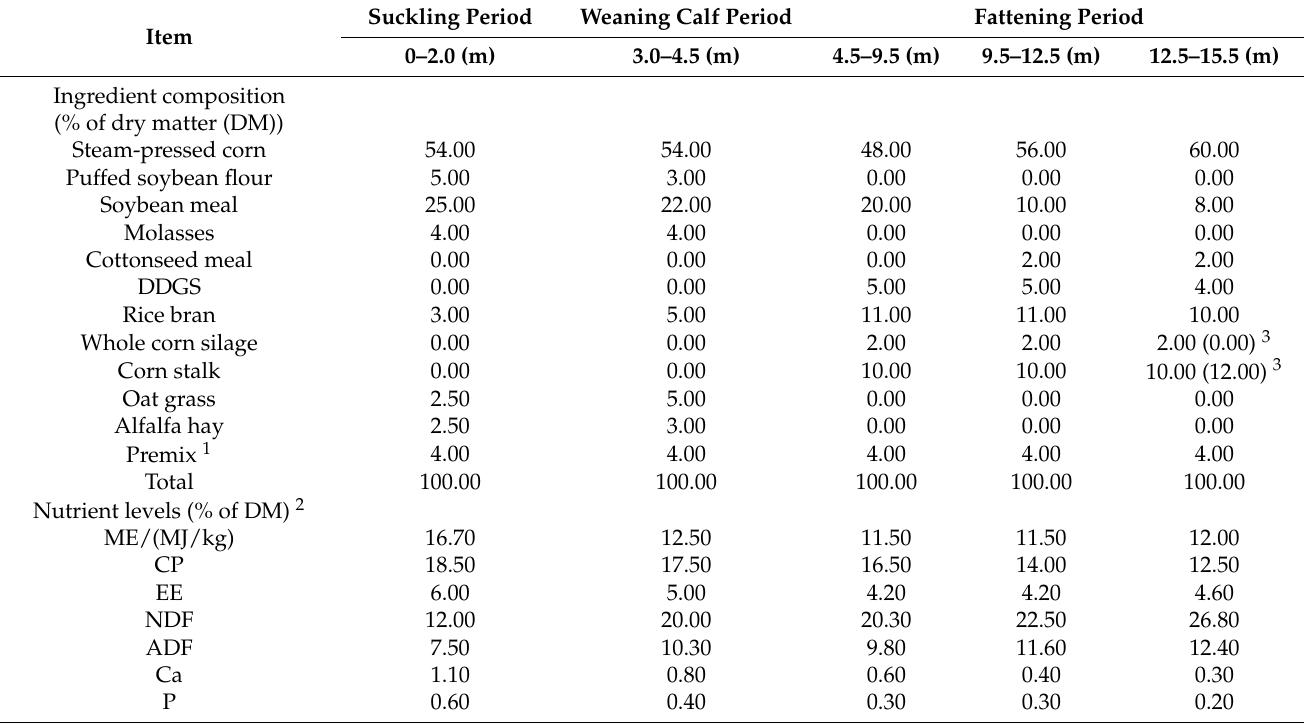
Table 1. Ingredient composition and nutrient levels of diets (DM